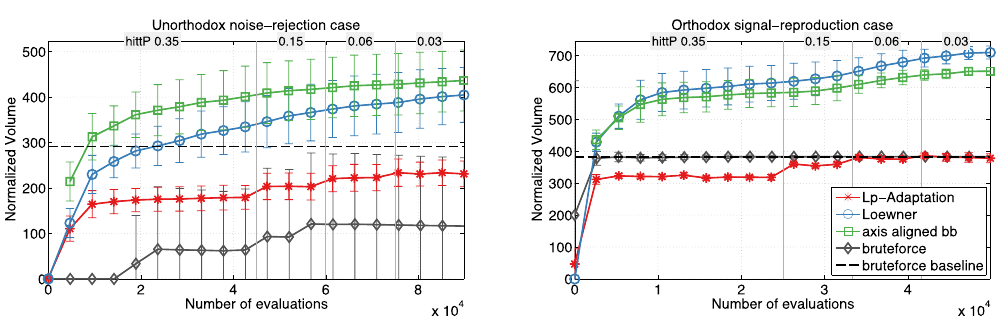
Figure 9. Averages and standard deviations of the normalized volume ( V n ) 23 estimation of the feasible region over ten independent runs of L p -Adaptation. We show the noise-rejection case for the unorthodox TCS (left column) and the signal-reproduction case for the orthodox TCS (right column) using an L 2 -ball proposal. The results for the L 1 proposal are visually indistinguishable and hence omitted. For comparison, the ground-truth baseline obtained by exhaustive brute-force sampling is shown as a dashed black line. Brute-force sampling using the same number of function evaluations as L p -Adaptation is shown in gray. The upper bounds obtained from Loewner ellipsoids and axes-aligned bounding boxes of the L p -Adaptation samples are shown in blue and green, respectively. Their large variance indicates that the feasible region is non-convex or